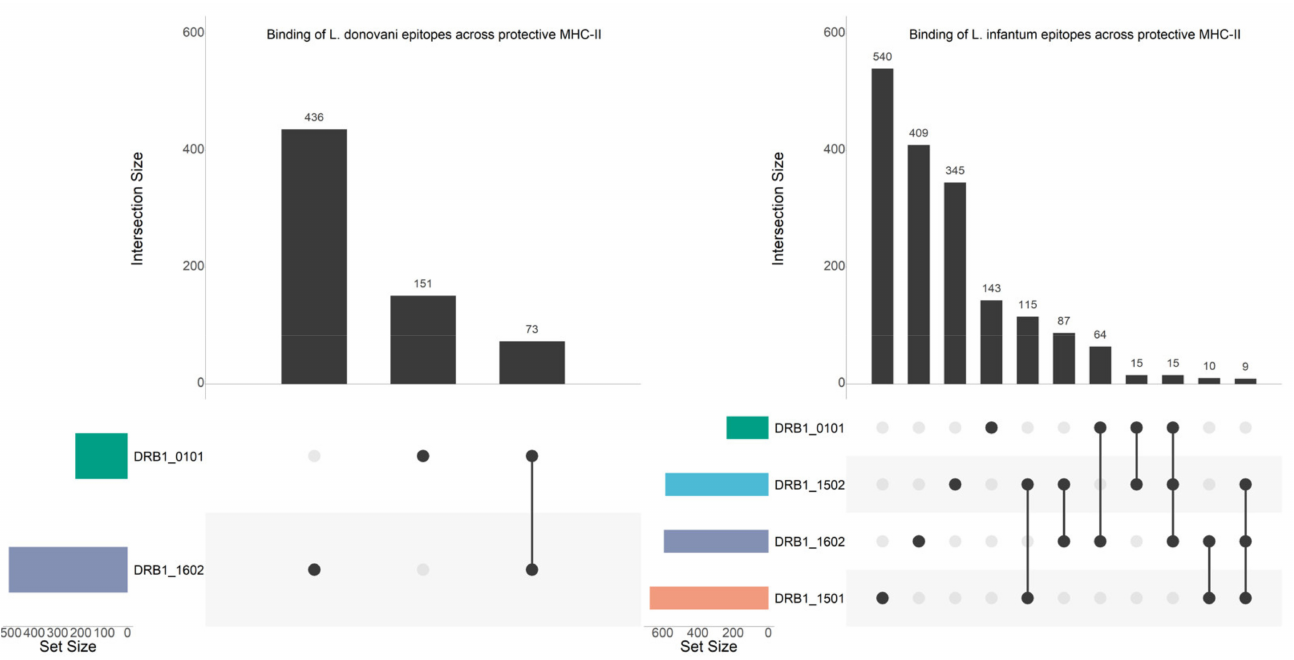
Figure 5. Upset Plots showing unique strong-binding epitopes of the VL-causing species ( L. donovani and L. infantum ) that bind across the protection-associated alleles known for these species. The set size denotes the total number of strong-binding epitopes predicted for each species, while the intersection size denotes the number of strong-binding epitopes shared across the species.